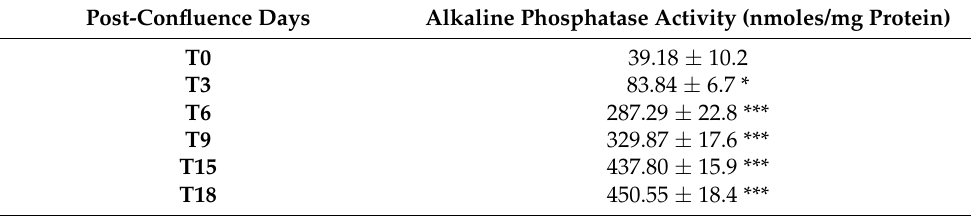
Table 1. Time course of alkaline phosphatase activity in CaCo-2 cells after reaching cell confluence. Post-Confluence